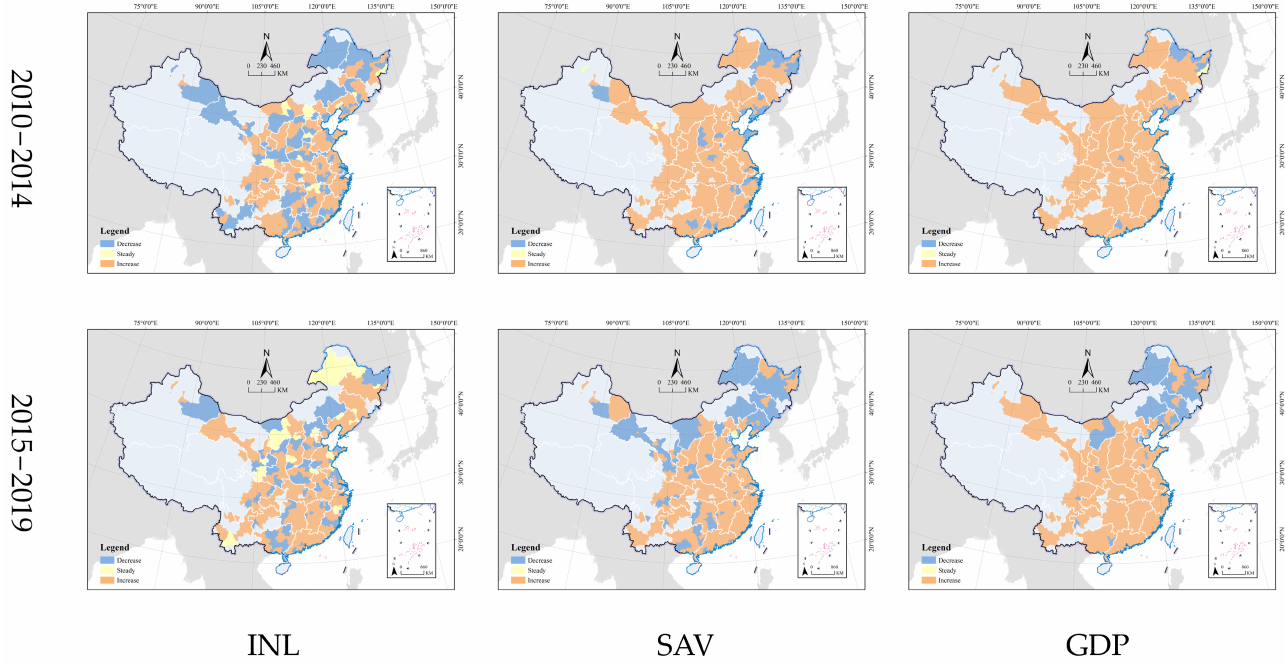
Figure 5. Distribution of industrial land and economic change